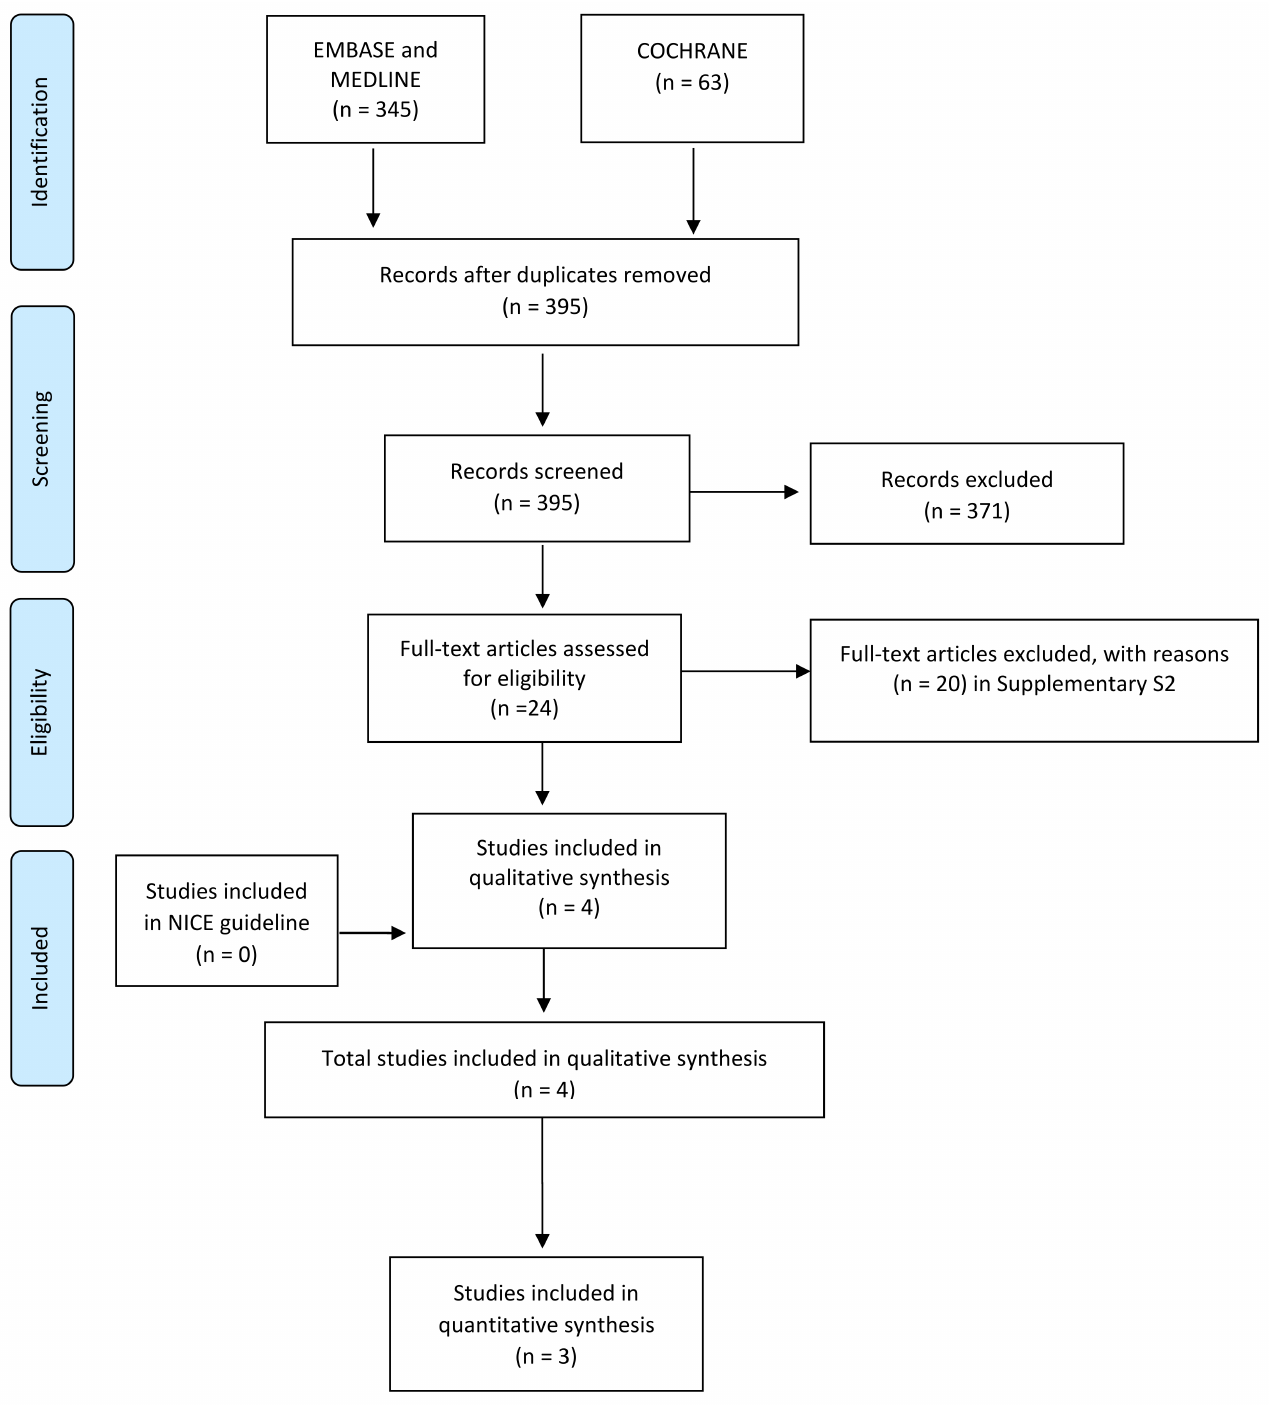
Figure 1. Flow chart of study